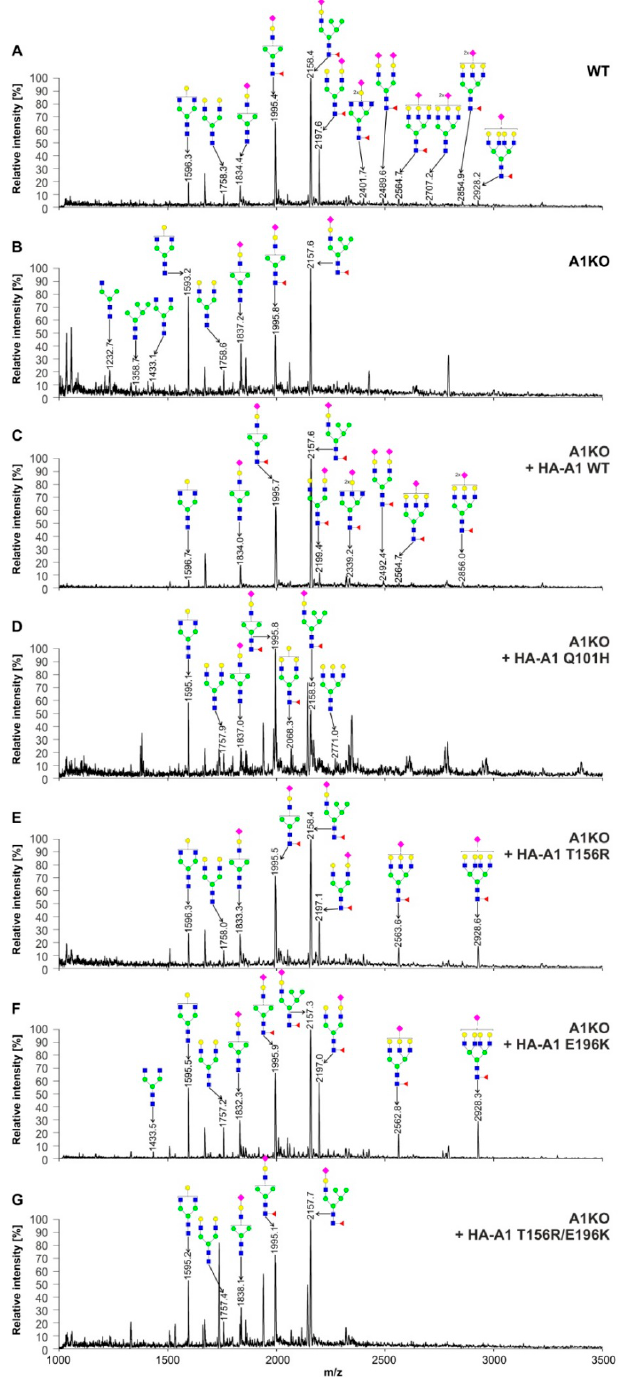
Figure 7. Structural analysis of N-glycans. MALDI-TOF MS characterization of 2-AB-labeled N-glycans released from cellular glycoproteins produced by the wild-type HEK293T cells (WT) ( A ), CST-deficient cells ( B ), CST-deficient cells expressing wild-type CST ( C ), CST-deficient cells expressing the Q101H CST variant ( D ), CST-deficient cells expressing the T156R CST variant ( E ), CST-deficient cells expressing the E196K CST variant ( F ) and CST-deficient cells expressing the T156R/E196K CST variant ( G ). N-Glycan composition was estimated using the GlycoWorkBench tool (2.1; EuroCarbDB). Identified peaks were labeled with mass information and cartoon representations of putative N-glycan chemical structures (based on biosynthetic knowledge). Green circles, mannose; blue squares, N -acetylglucosamine; yellow circles, galactose; red triangles, fucose; pink diamonds, sialic acid. A1,